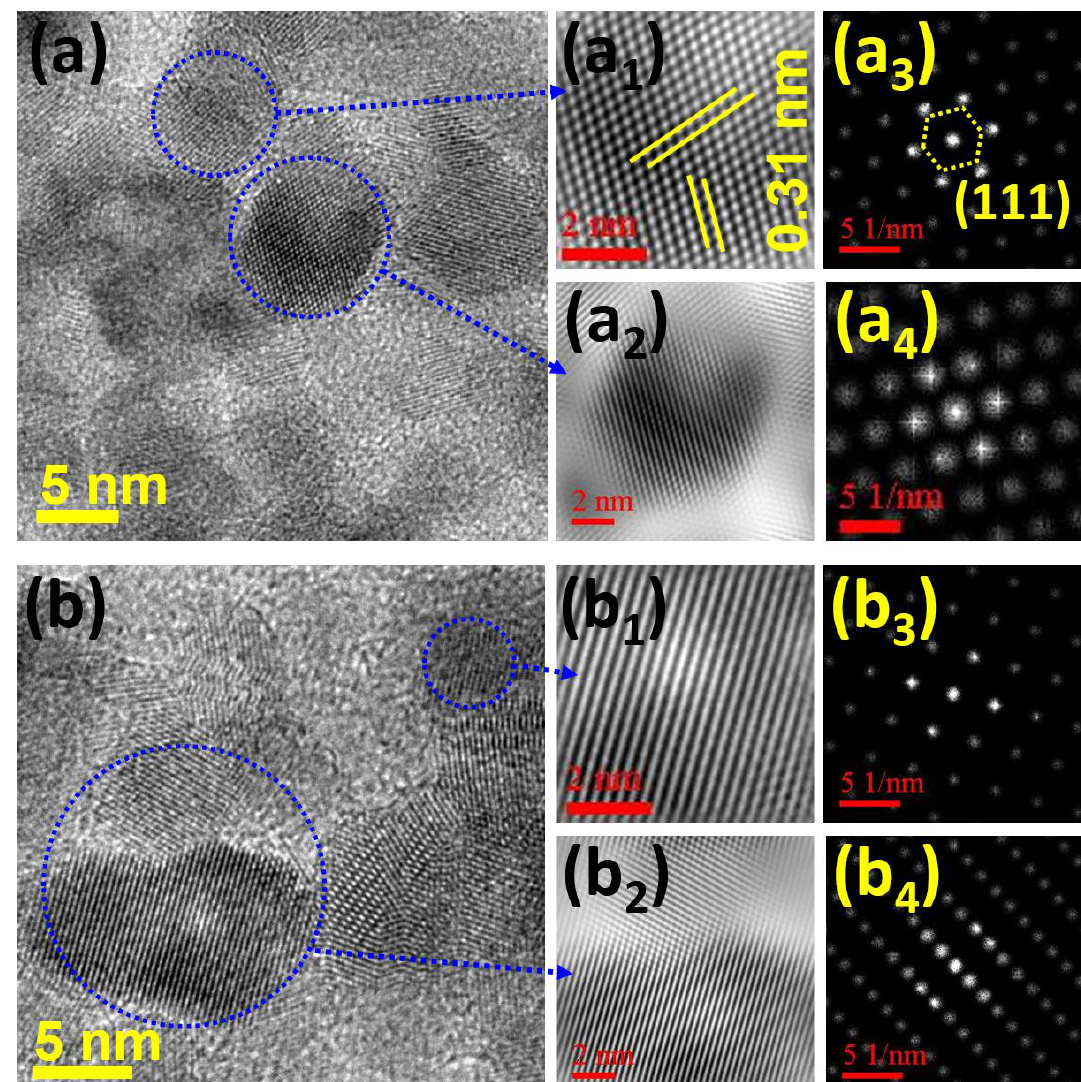
Figure 3. ( a , b ) High-resolution transmission electron microscopy (HRTEM) images: ( a 1 , a 2 ) and ( b 1 , b 2 ) specific area HRTEM images and their corresponding ( a 3 , a 4 ) and ( b 3 , b 4 ) FFT patterns of the ZnS QDs.